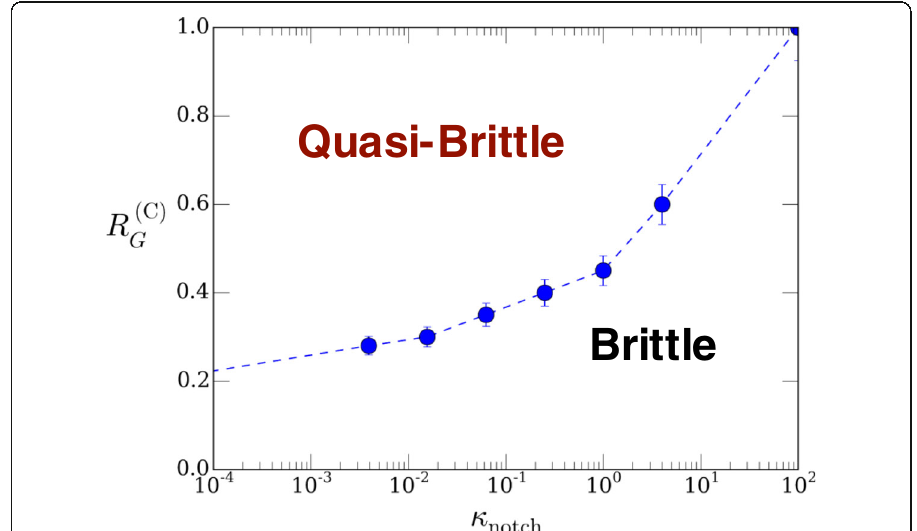
Fig. 9 Phase diagram of the studied